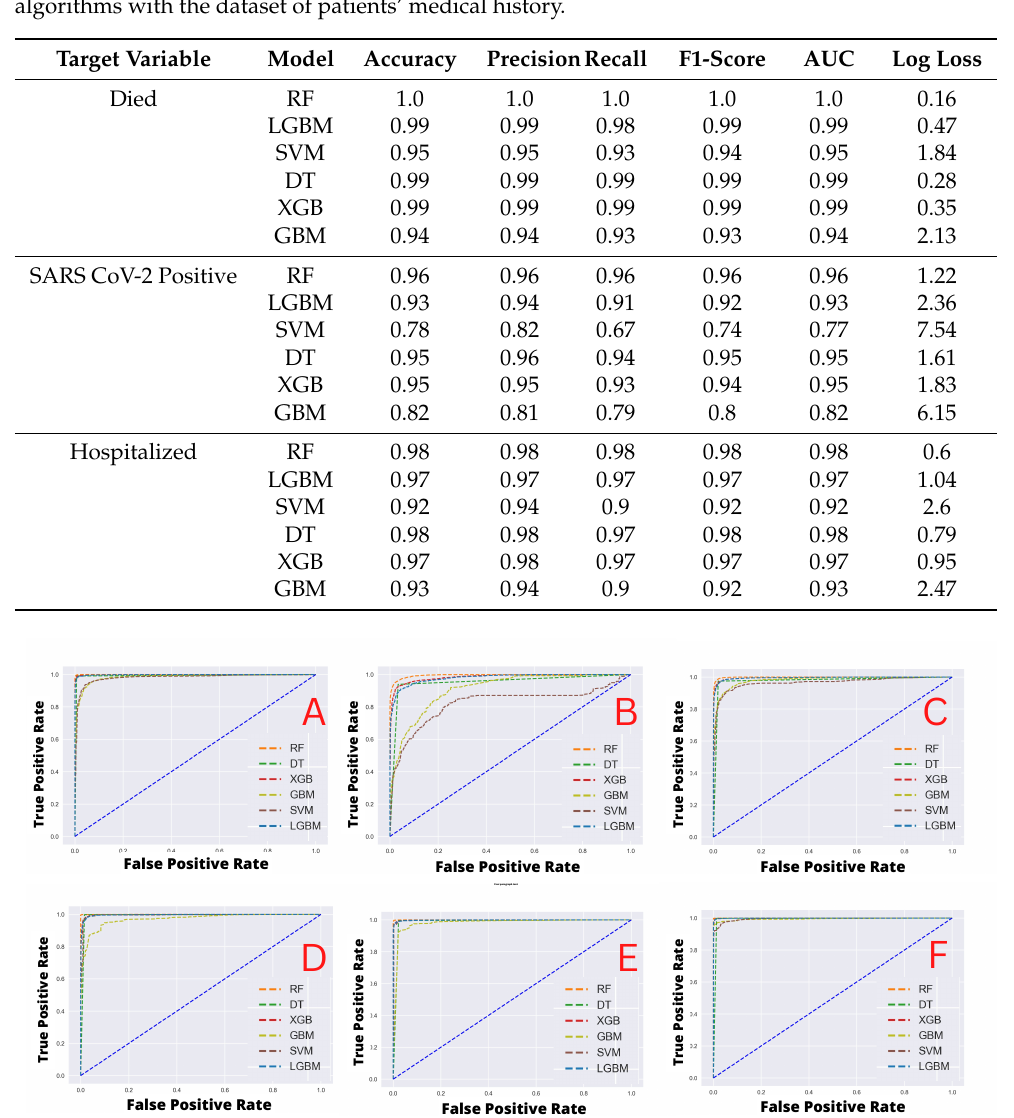
Figure 6. Area Under the ROC curves for the machine learning model evaluation. ( A ). classification of died patients’ using patients’ medical history dataset; ( B ). classification of SARS-CoV-2 positive patients’ using patients’ medical history dataset; ( C ). classification of hospitalised patients’ using pa- tients’ medical history dataset; ( D ). classification of died patients’ using patients’ reaction dataset; ( E ). classification of SARS-CoV-2 positive patients’ using patients’ reaction dataset; ( F ). classification of hospitalized patients’ using patients’ reaction